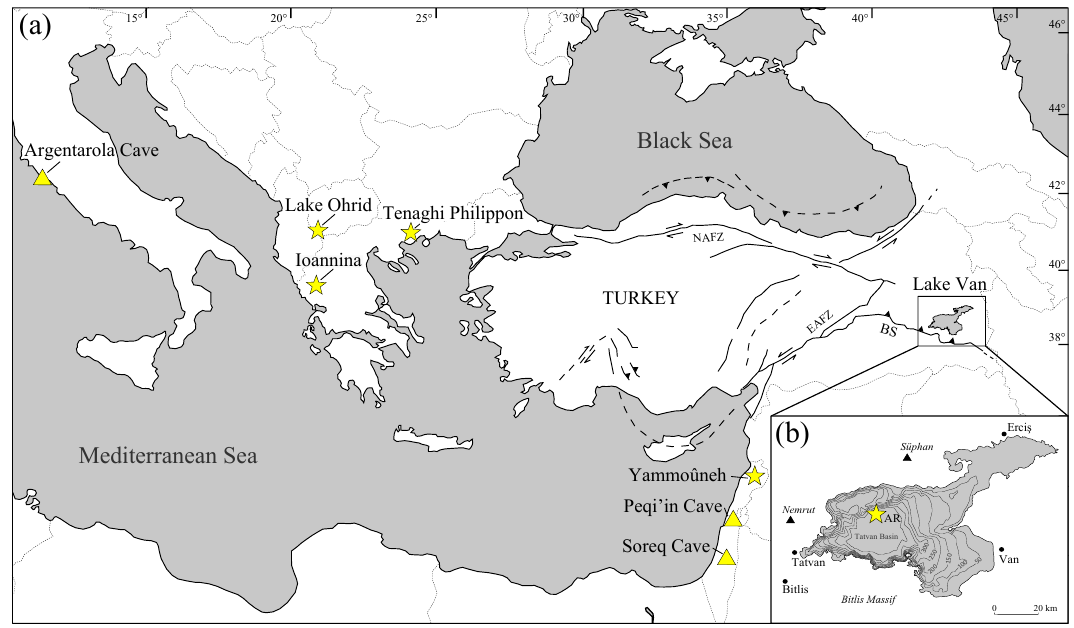
Figure 1. Map of the eastern Mediterranean region showing major tectonic structures in Turkey. (a) Location of key Mediterranean and Near East pollen sites (stars) and speleothem records (triangle) mentioned in the text. (b) Bathymetry of Lake Van including the Ahlat Ridge drill site (AR; star). The black triangle indicates the positions of the active Nemrut and Süphan volcanoes. NAFZ: North Anatolian Fault zone; EAFZ: East Anatolian Fault zone; BS: Bitlis